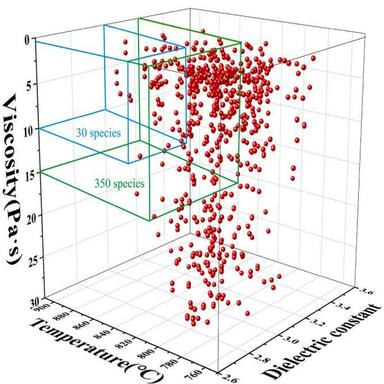
Threshold screening of benzoxazine monomers.